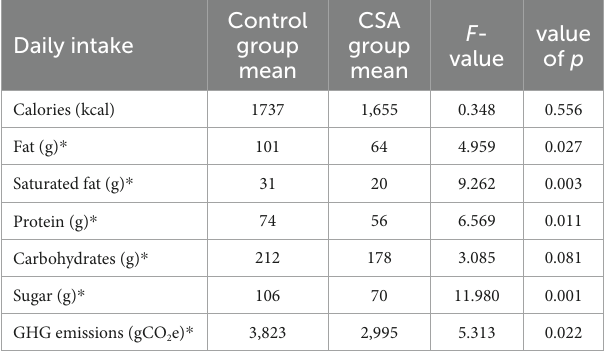
TABLE 3 Results from ANOVA run for aggregated daily food consumption, comparing the control group with the CSA group for key variables indicating health and sustainability of